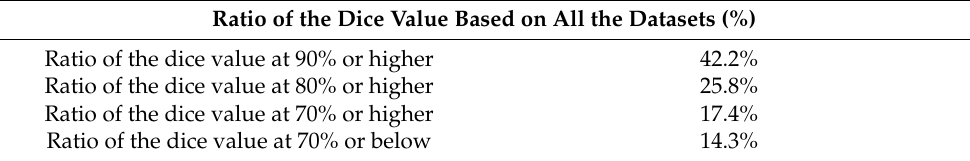
Table 2. Ratio of the dice value based on all the datasets. Ratio of the Dice Value Based on All the Datasets (%) Ratio of the dice value at 90% or higher 42.2% Ratio of the dice value at 80% or higher 25.8% Ratio of the dice value at 70% or higher 17.4% Ratio of the dice value at 70% or below 14.3%